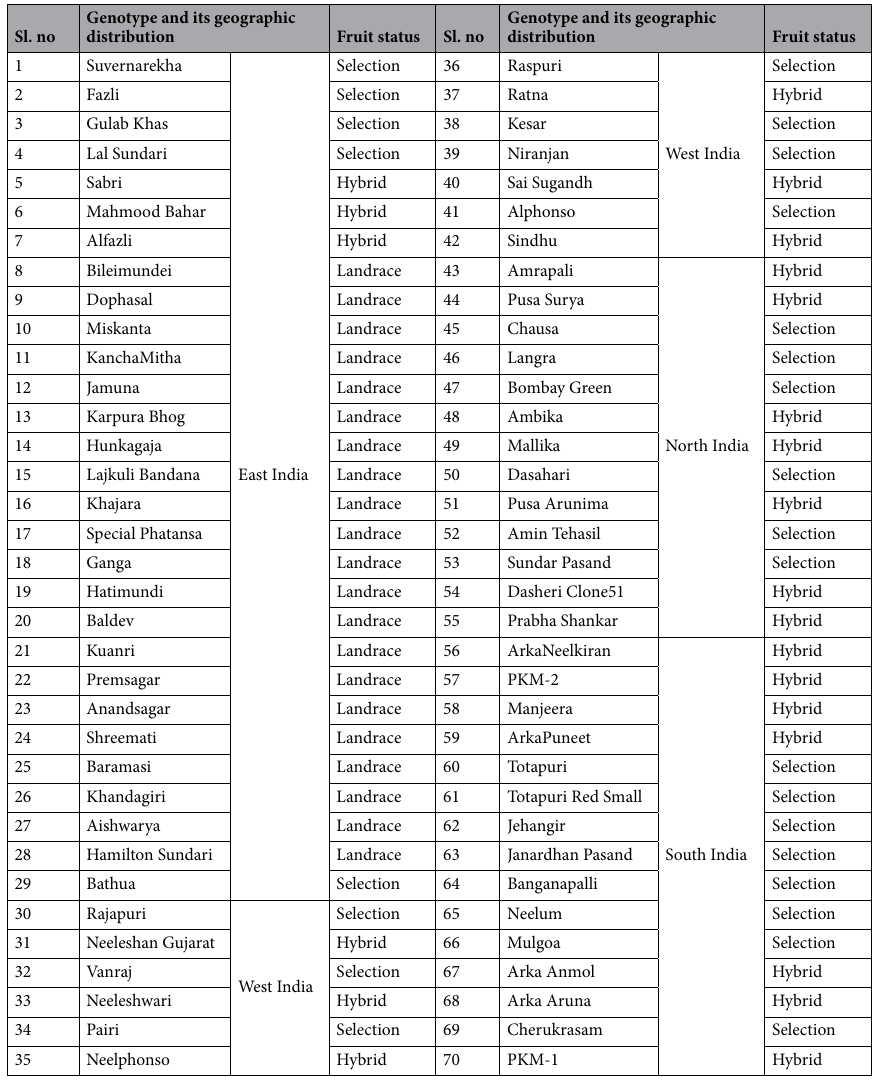
total of 208 primers yielded 12.60 average bands per primer among all genotypes of mangoes under investigation (Tables 1, 2). Genetic variability within and among populations and gene flow.